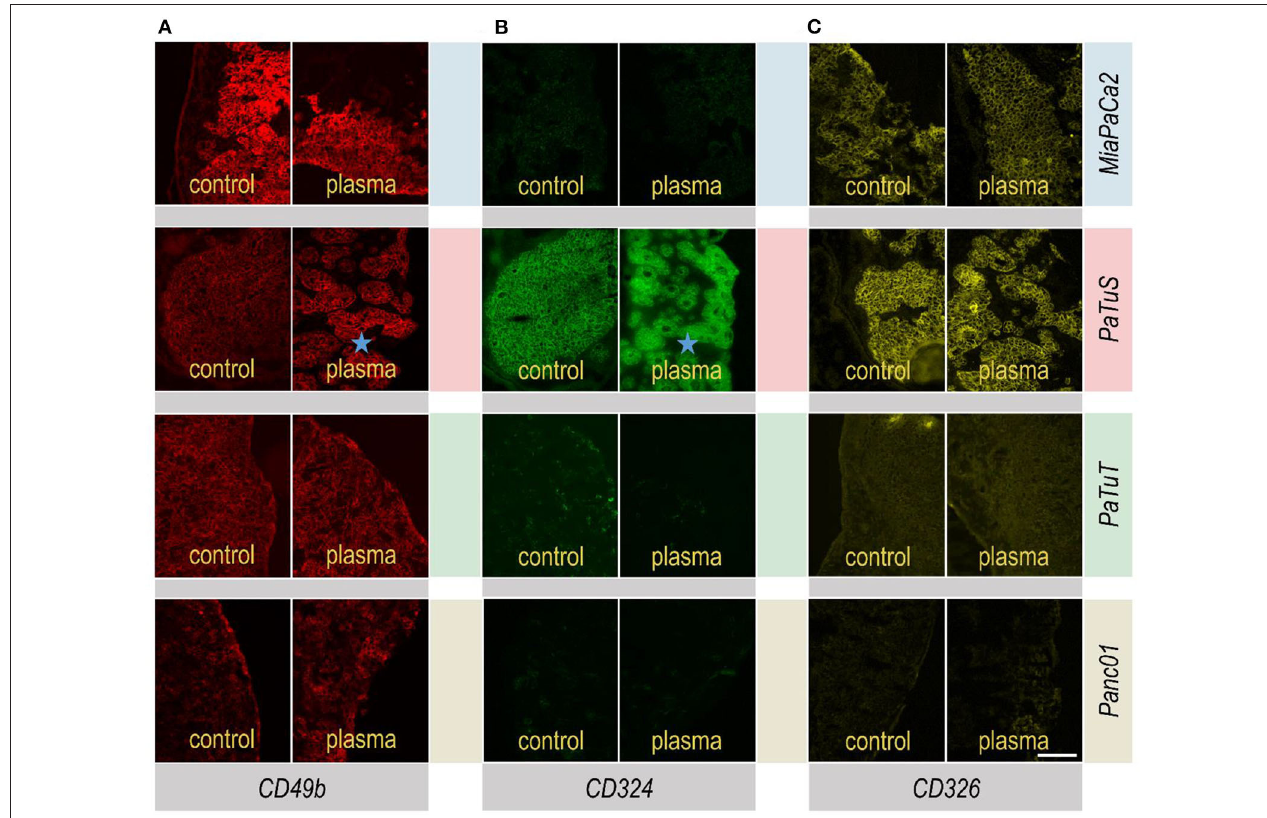
FIGURE 2 | Adhesion marker profile of in ovo -grown tumor tissue was unaffected by plasma treatment. (A) Tumor tissue from in ovo -grown MiaPaCa2, PaTuS, PaTuT, and Panc01 cells that were stained with anti-CD49b (red), (B) anti-CD324 (green), (C) and anti-CD326 (yellow) antibodies 24h after 2 × 60s of plasma treatment. The magnification of all images was 20 × . Changes in growth morphology are indicated with stars ( ⋆ ). The images are representatives from at least 4–5 eggs per group carrying one tumor each. Scale bar is 500 µ m.